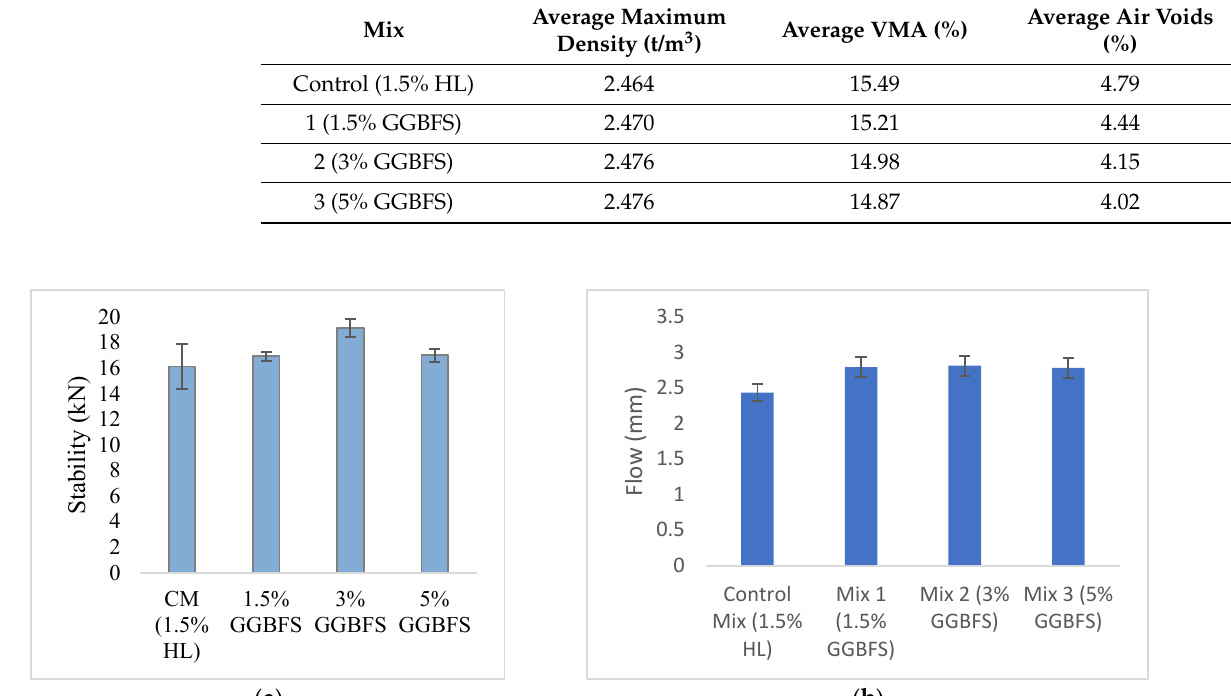
Figure 4. ( a ) Marshall stability and ( b ) flow values of the mixtures.